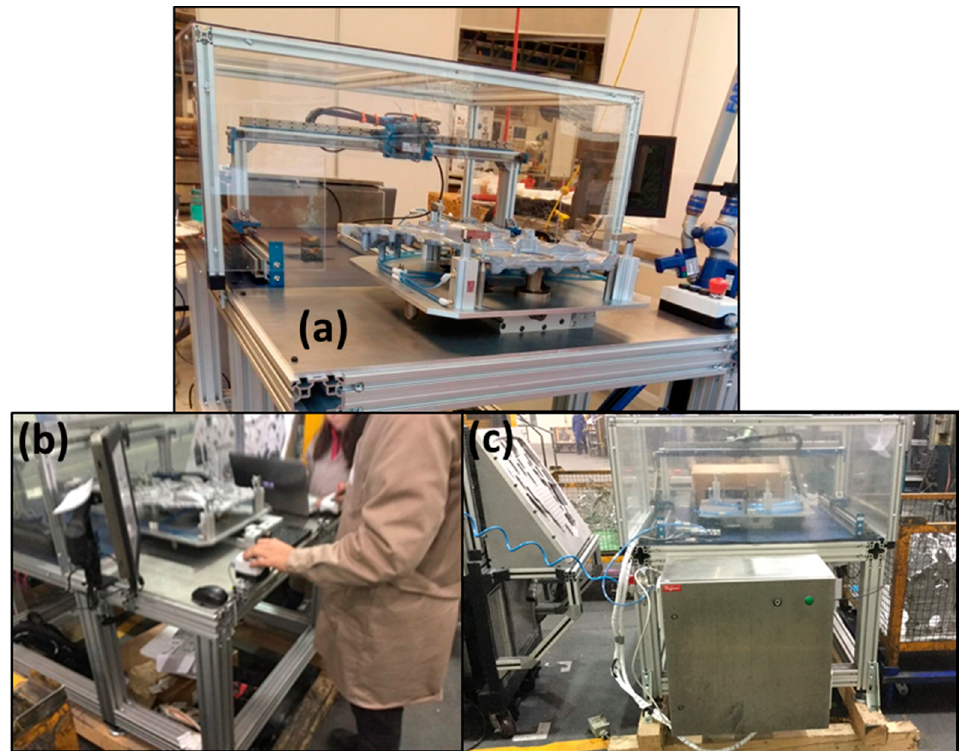
Figure 13. ( a ) Prototype of the machine in the laboratory, and ( b , c ) in use on the shop